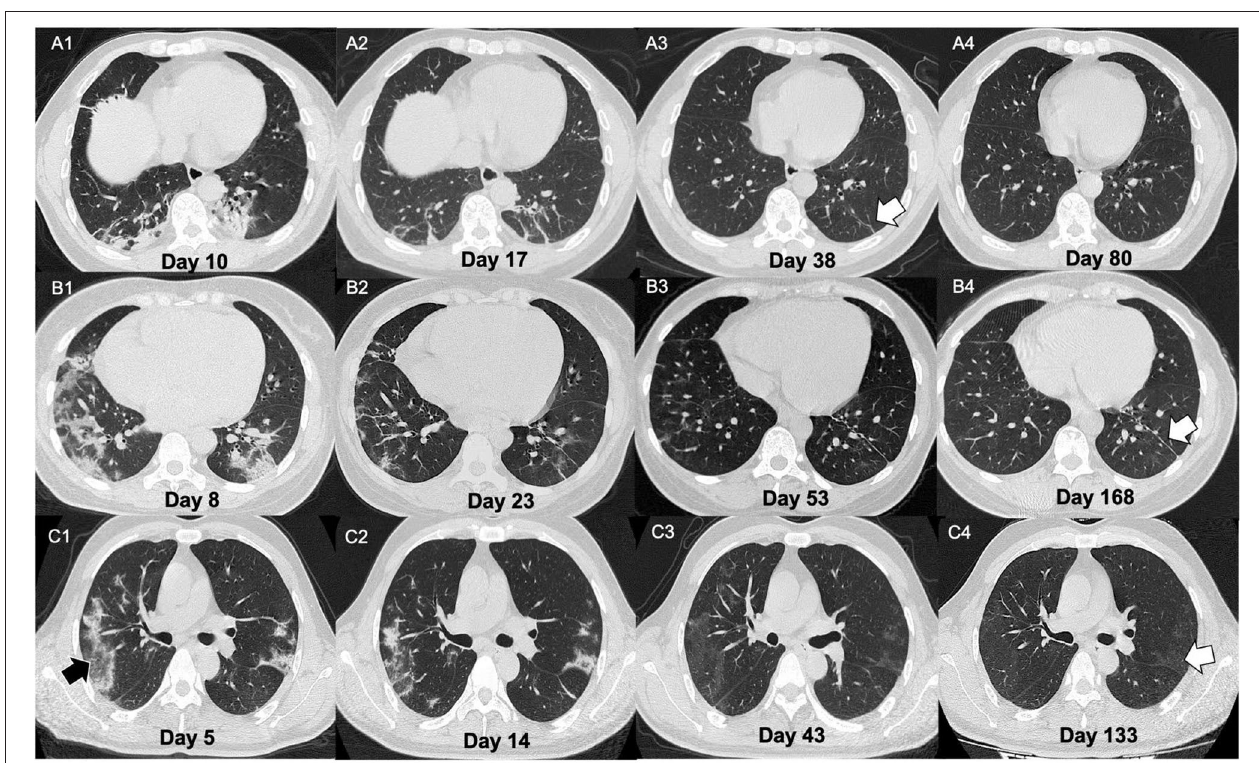
FIGURE 3 | Illustration of three patients with different CT manifestations in the follow-ups. (A) A 51-year-old male presented with fever for 9 days. On admission, the chest CT showed multiple patchy lesions (mixed lesions with dominant consolidation) and fibrotic changes (A1) . The man was then confirmed as infected with COVID-19 by nucleic acid amplification test NAAT. After treatment, the lesions showed evident absorption on day 17 from onset (A2) . He was discharged on day 25 of the course. Some parenchymal bands (white arrow) remained in week 2 of follow-up (A3) but were absolutely absorbed on day 80 after onset (A4) . (B) A 34-year-old female presented with fever and diarrhea for 3 days. On admission, the chest CT showed large patchy lesions (mixed lesions with dominant GGO) (B1) . The woman was then confirmed as COVID-19 by NAAT. After treatment, the lesions showed evident absorption. On day 23 of the course (B2) , the patient was discharged. Parenchymal bands could be observed at 1 and 4 months after discharge [ (B3,B4) , white arrow]. (C) A 48-year-old male presented with fever and cough for 24 days. On admission, his chest CT showed multiple patchy lesions with consolidative changes (C1) with reversed halo signs observed (black arrow). The man was then confirmed as COVID-19 by NAAT. After treatment, the lesions showed evident absorption on day 33 from onset (C2) . The patient was discharged 2 days later. However, pulmonary lesions with GGO opacification were not completely absorbed at the 1- and 3-month follow-ups [ (C3,C4) , white